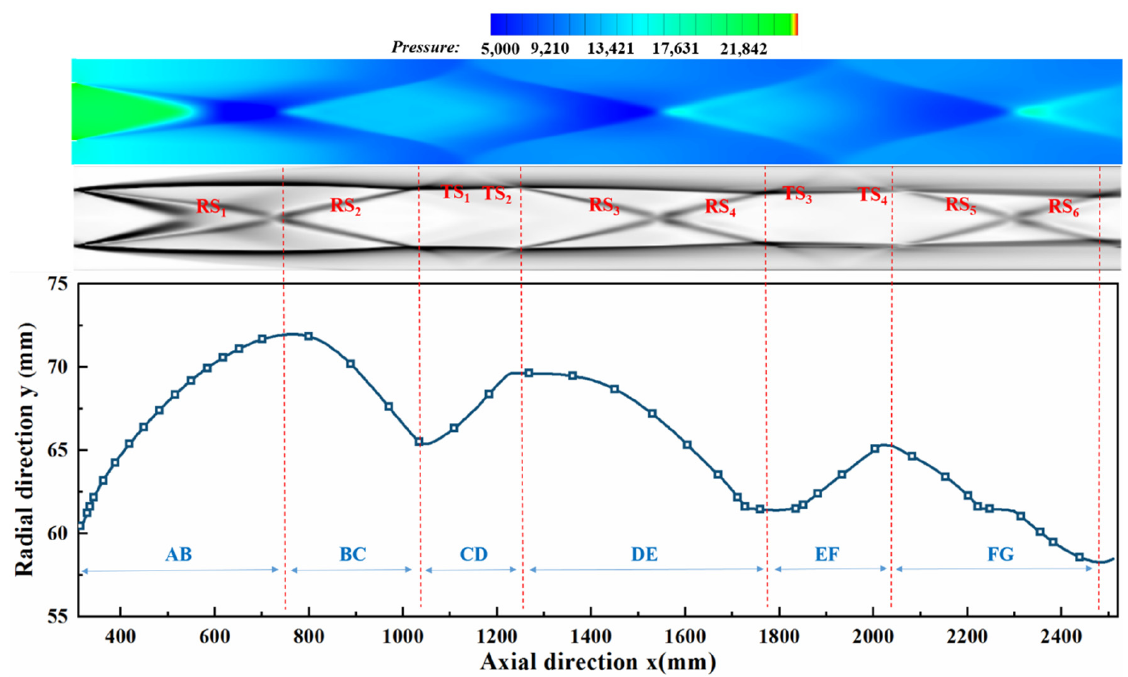
Figure 11. Numerical synthetic Schlieren (top image) and primary flow boundary development (bottom image) when the mixing chamber contraction angle φ = 0°.